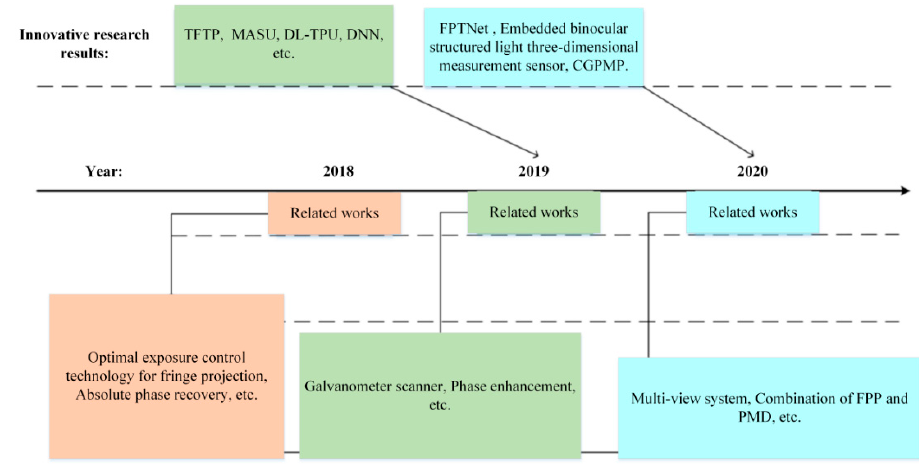
Figure 6. Raster projection technology development.